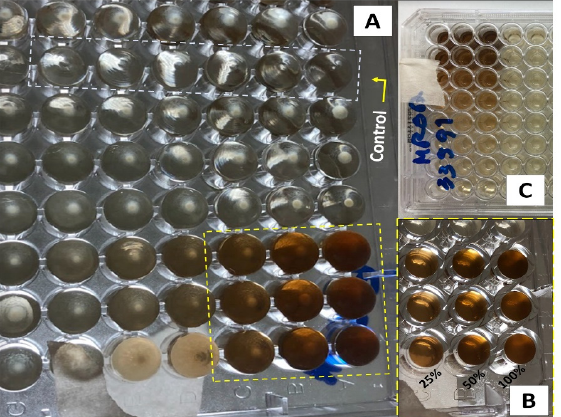
Figure 3. Microplate inhibitory dose study for resistant S. aureus (MRSA). ( A ) Photograph of the bottom of the microplates highlighting the wells with the control group and the 48 wells with the extract. ( B ) Enlarged photograph for the wells with 100, 50, and 25% of the extract. ( C ) Photograph of the upper part of the plate with the type of bacteria (MSRA). For this test, a liquid medium was introduced in wells of a microplate and, through successive dilutions, the minimum concentration of the extract that inhibits bacterial growth after 48 h of culture was determined. The solution in the wells that contain the